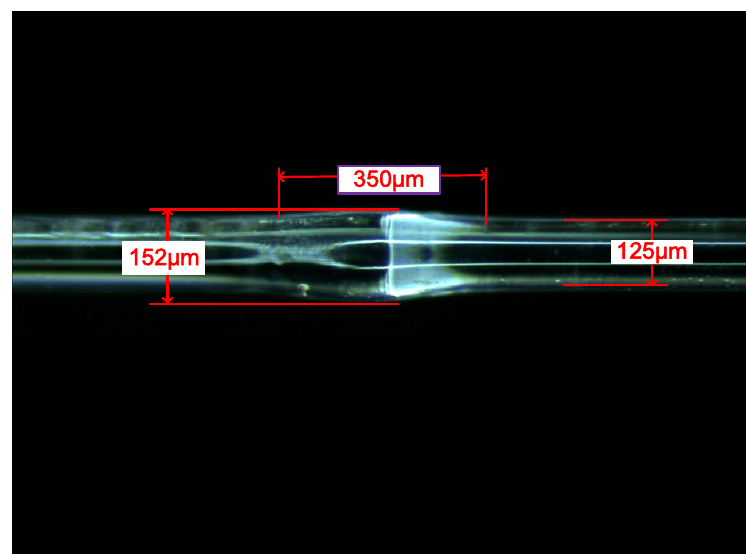
Figure 5. The waist-enlarged bitaper in SMBMS MZI.